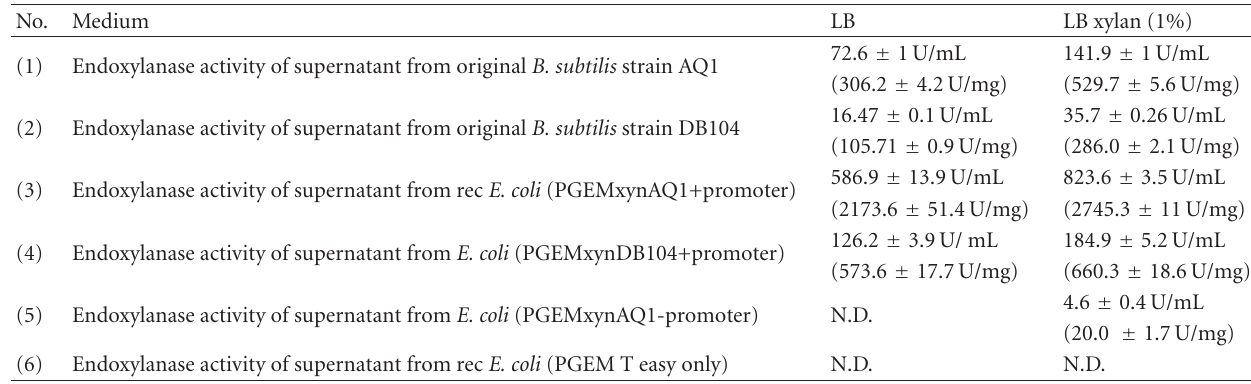
Table 2: Comparison of the activity at 55 ◦ C pH 7 of the supernatant from the fermentation broth after 24 hours of cultivation at 37 ◦ C in the di ff erent medium content of B. subtilis AQ1, B. subtilis DB104, and recombinant E. colis at the same OD OR cell number per ml. The given values in activity assays are the means of triplicates independent experiment ( ± the standard